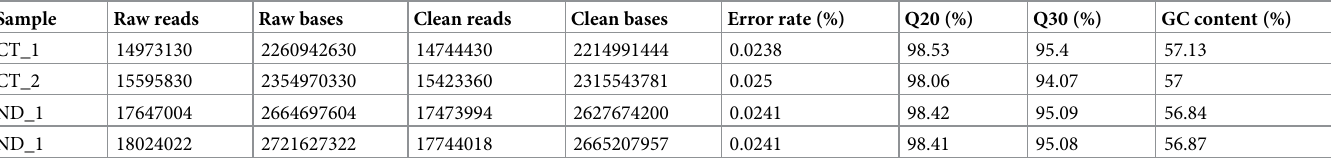
Table 1. Summary of transcriptome sequencing data of P . cruentum under control (CT) and nitrogen deprivation (ND). Sample